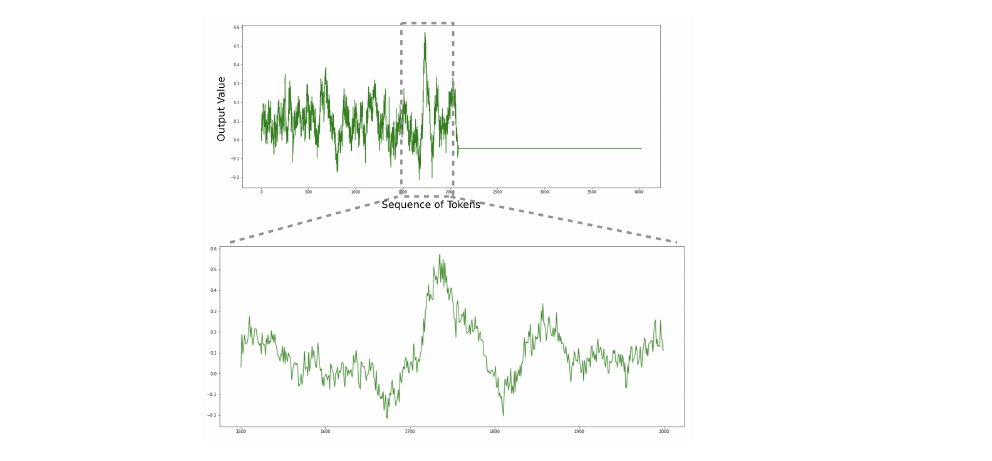
Figure 7. Output of the first convolutional layer after convolving one of the 32 filters over the input provided. The maximum value corresponds to the token in position 1739 and the minimum corresponds to the token in position 1673. The sample shown consists of less than 1500 tokens, hence the document is padded up to